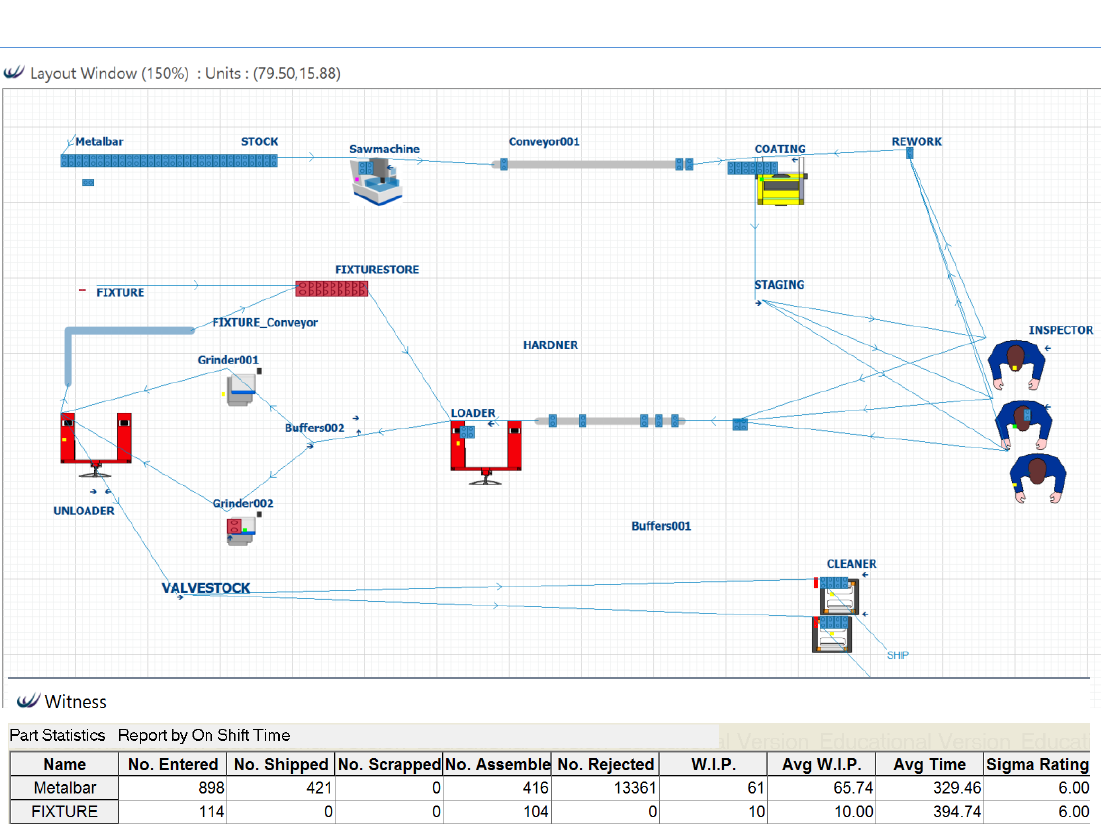
Figure 14. Re-engineered and optimized process.